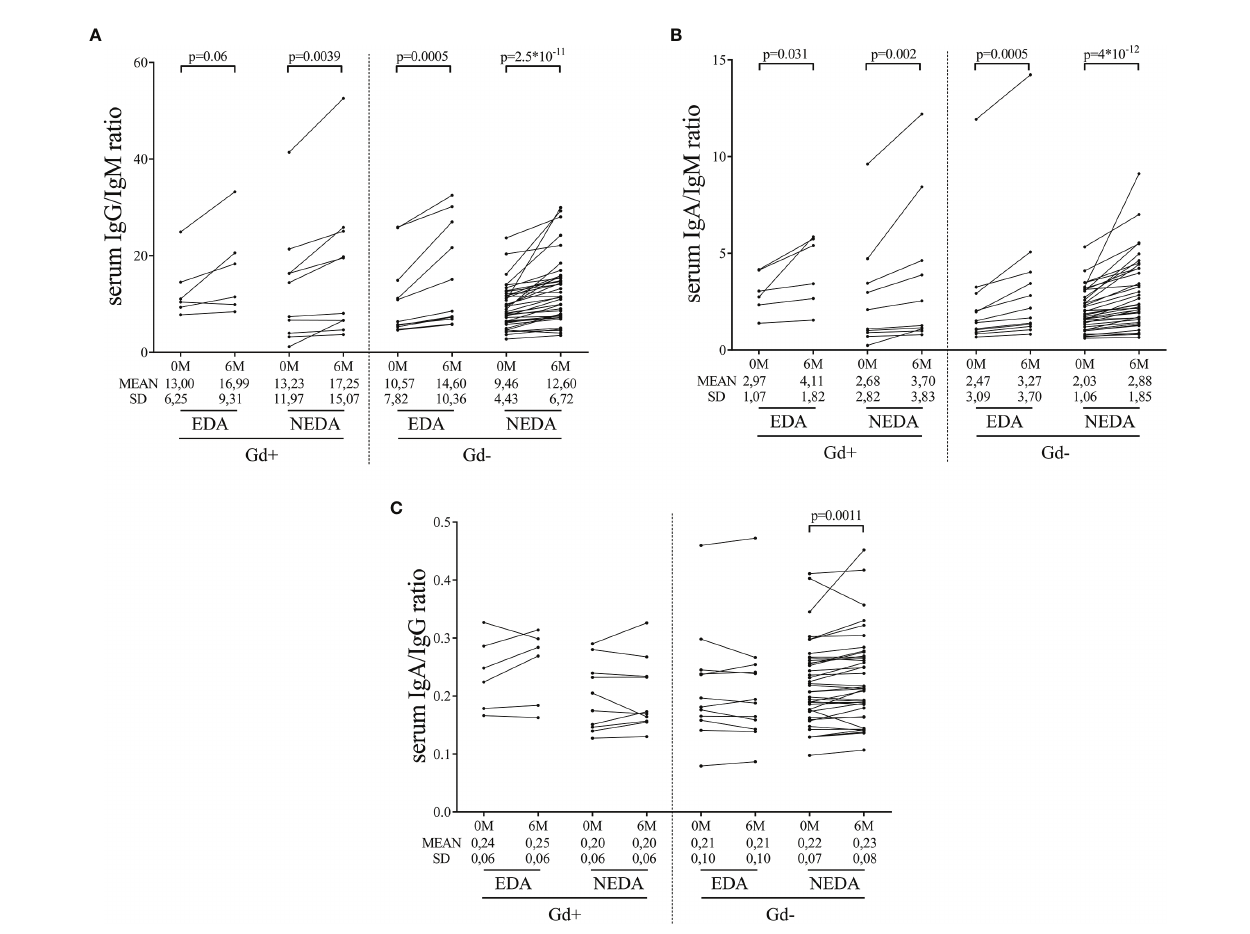
FIGURE 5 | Changes in serum immunoglobulin ratios induced by ocrelizumab treatment. Serum samples were analyzed before (0M) and at 6 months (6M) of ocrelizumab treatment and classi fi ed based on their in fl ammatory status (presence [Gd+] or absence [Gd-] of gadolinium enhancing lesions at baseline) and response (NEDA or EDA) to treatment at one year of follow-up. N was 6, 10, 12 and 41 in Gd+ EDA, Gd+ NEDA, Gd- EDA and Gd- NEDA, respectively. Graphs showing IgG/ IgM (A) , IgA/IgM (B) and IgA/IgG (C) ratios. SD, Standard